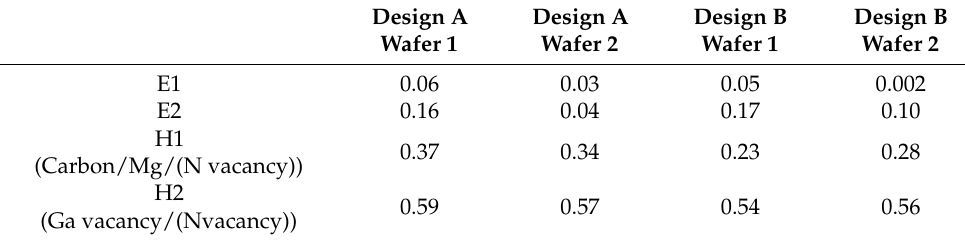
Table 2. Table of the results after traps energy levels extraction.